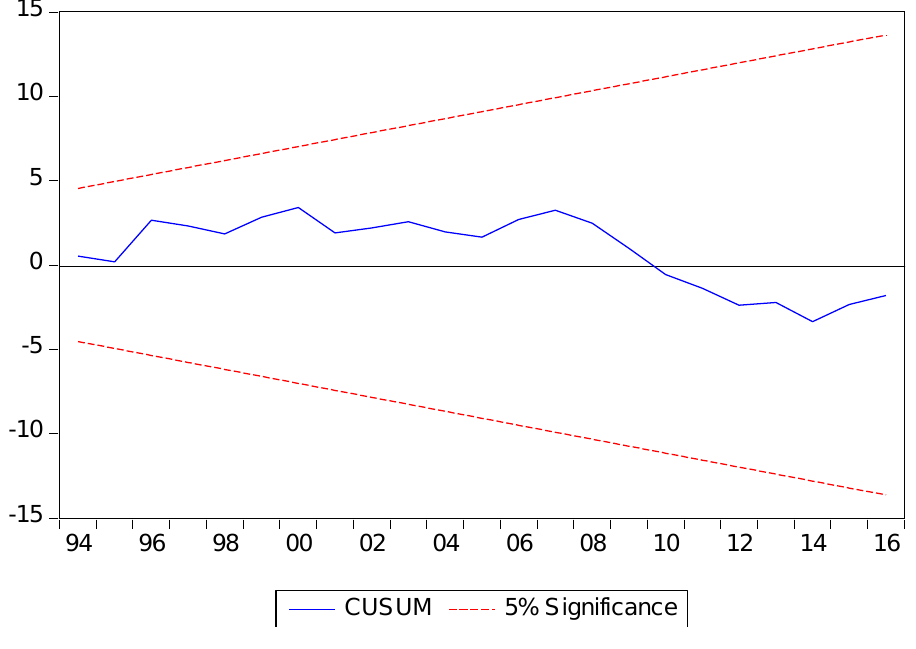
Figure 1. The plot of the cumulative sum of recursive residuals. Figure 2. The plot of the cumulative sum of squares of recursive residuals.